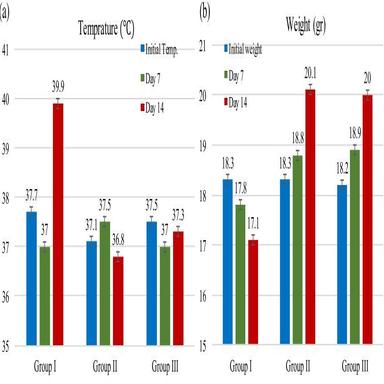
Average body temperature and weight of different groups of laboratory rats after 7 and 14 days of treatment.